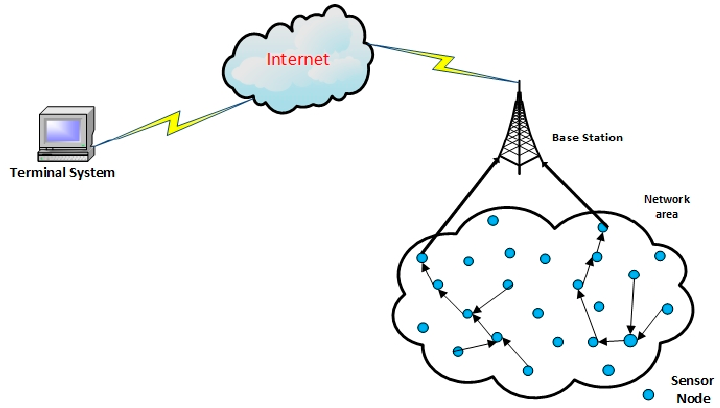
Figure 1. Wireless sensor networks (WSNs) architecture.